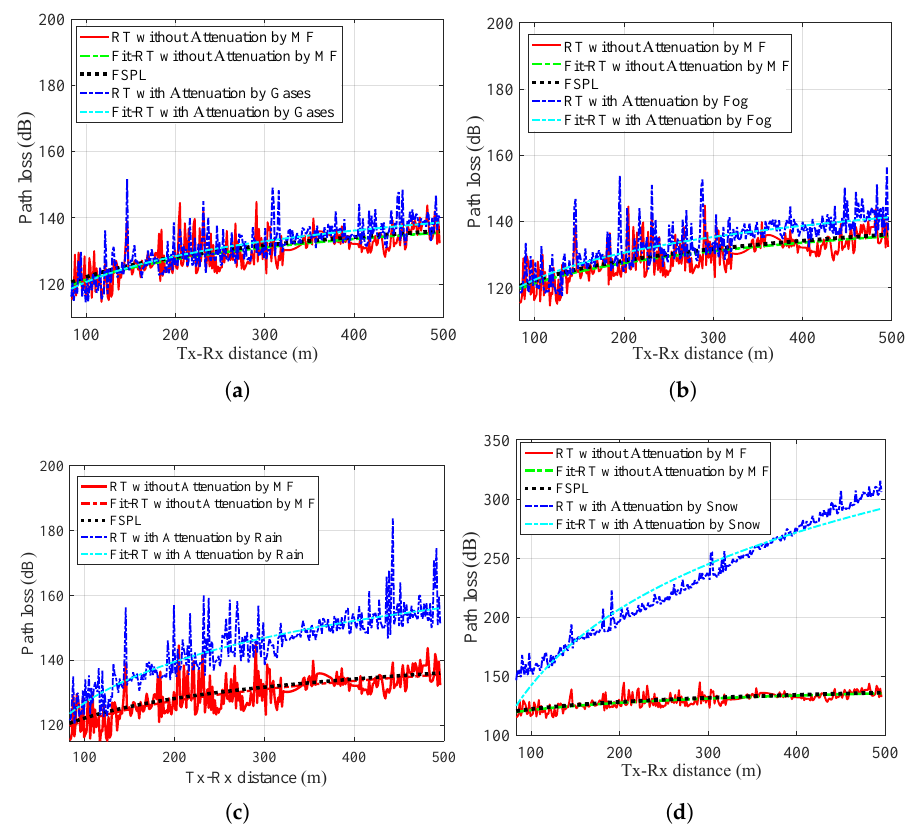
Figure 8. Path loss, ( a ) by Gases; ( b ) by Fog; ( c ) by Rain; ( d ) by